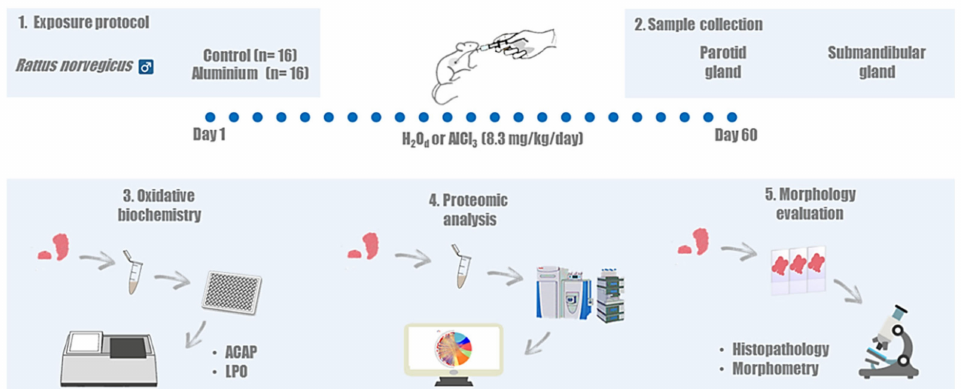
Figure 5. Methodological steps of the present study. ( 1 ) Description of experimental groups and exposure to aluminum chloride (AlCl 3 ) or distilled water (H 2 Od). ( 2 ) Collection of the biological samples. ( 3 ) Oxidative biochemistry assays performed by measuring the antioxidant capacity against peroxyl radicals (ACAP) and lipid peroxidation (LPO) levels. ( 4 ) Proteomic profile analysis performed by mass spectrometry system and ( 5 ) morphology